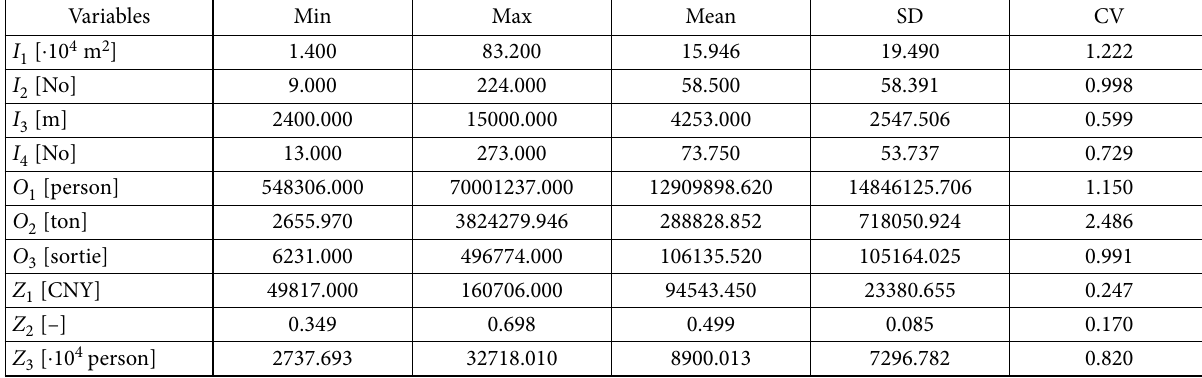
Table 2. Descriptive statistics of the collected data of all variables Variables